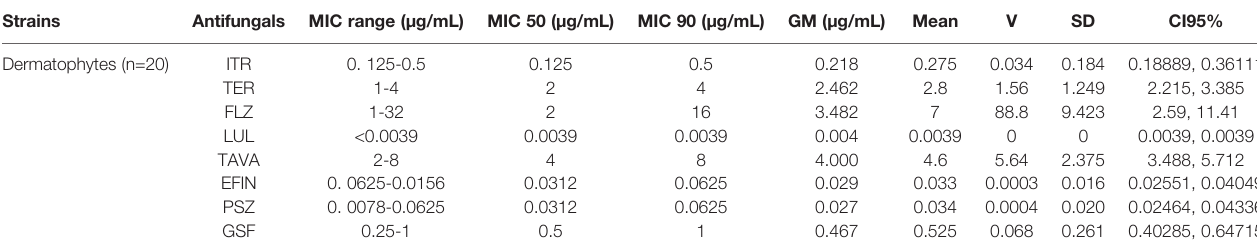
TABLE 5 | The geometric mean, MIC ranges, MIC50 and MIC90 values obtained by testing the susceptibility of dermatophytes to each antifungal agent. Strains